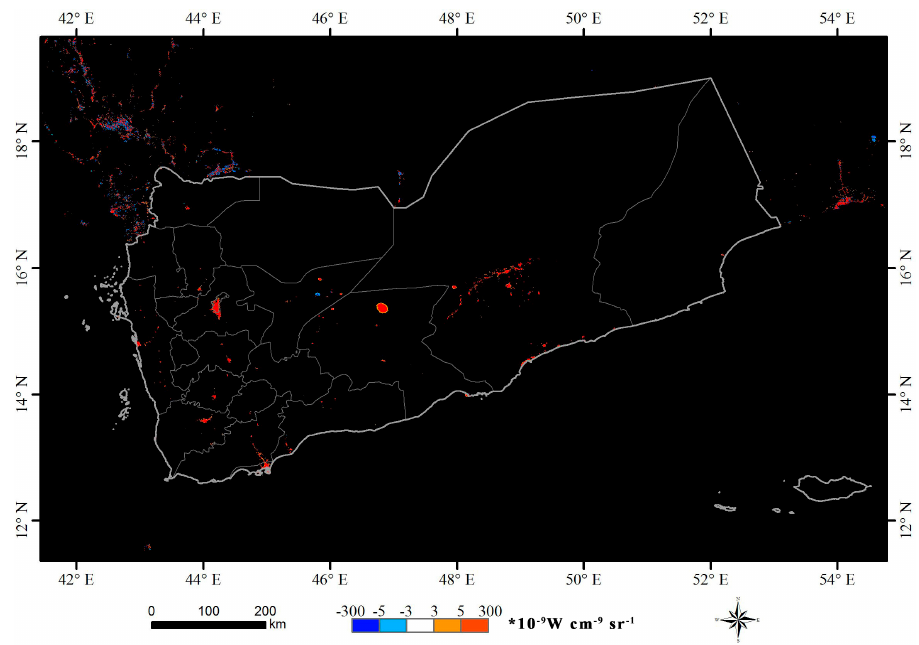
Figure 12 . The spatial patterns of change in nighttime light during conflict period. Figure 12. The spatial patterns of change in nighttime light during conflict